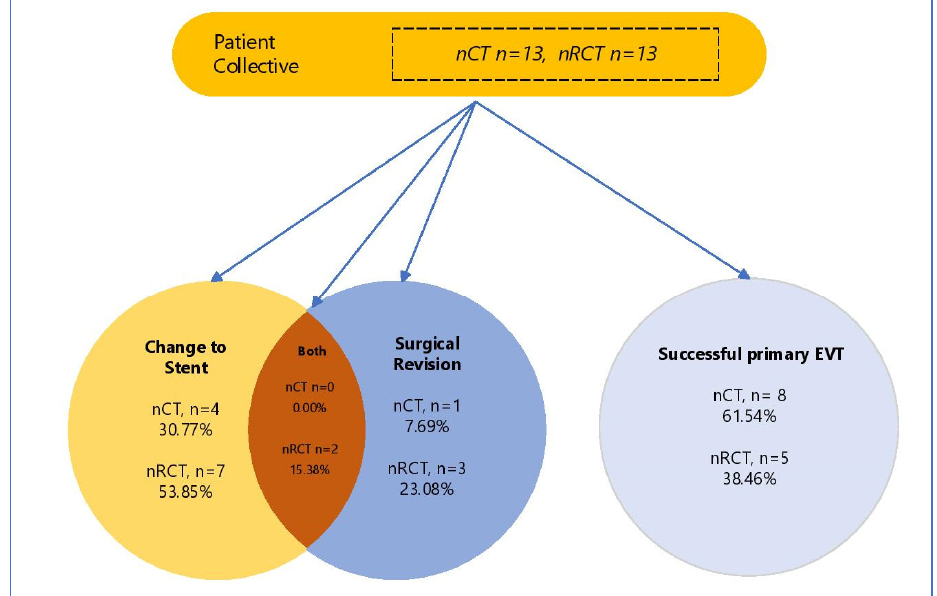
Figure 1. Study population according to treatment modality of AL. EVT—EndoVAC Therapy, nCT—neoadjuvant chemoptherapy, nRCT—neoadjuvant chemoradiotherapy.